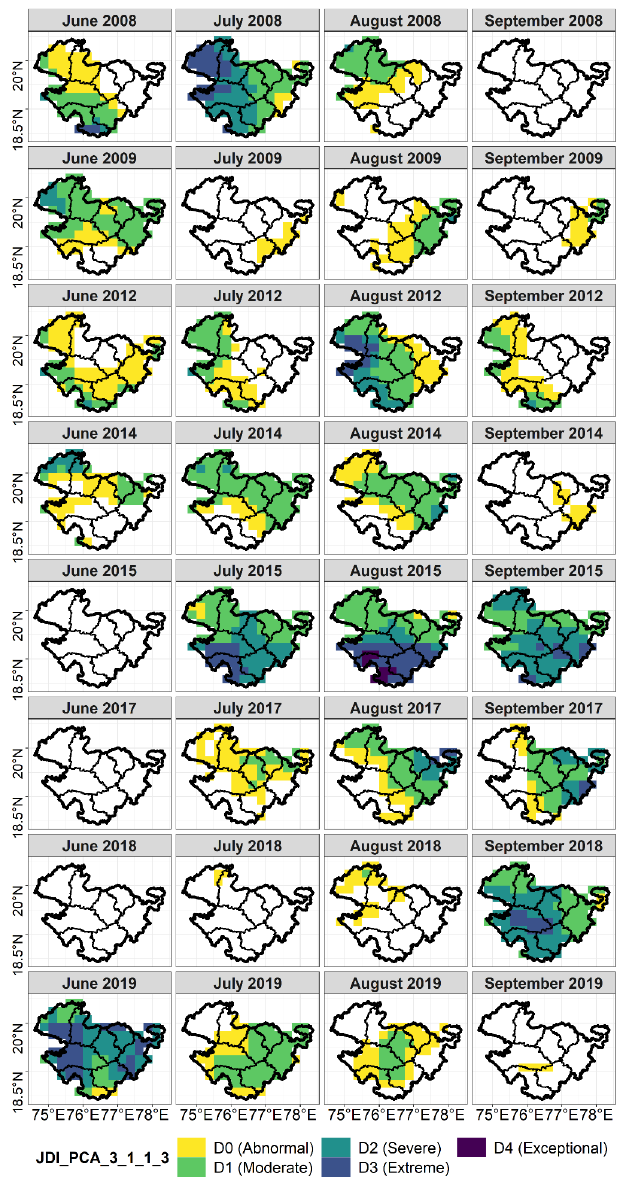
Figure 5. Spatial distribution of drought severity over Marathwada in Kharif season of different drought years detected by using JDI_PCA. Various subfigures are vertically stacked for better com- parison among different years (white areas represent no drought condition).